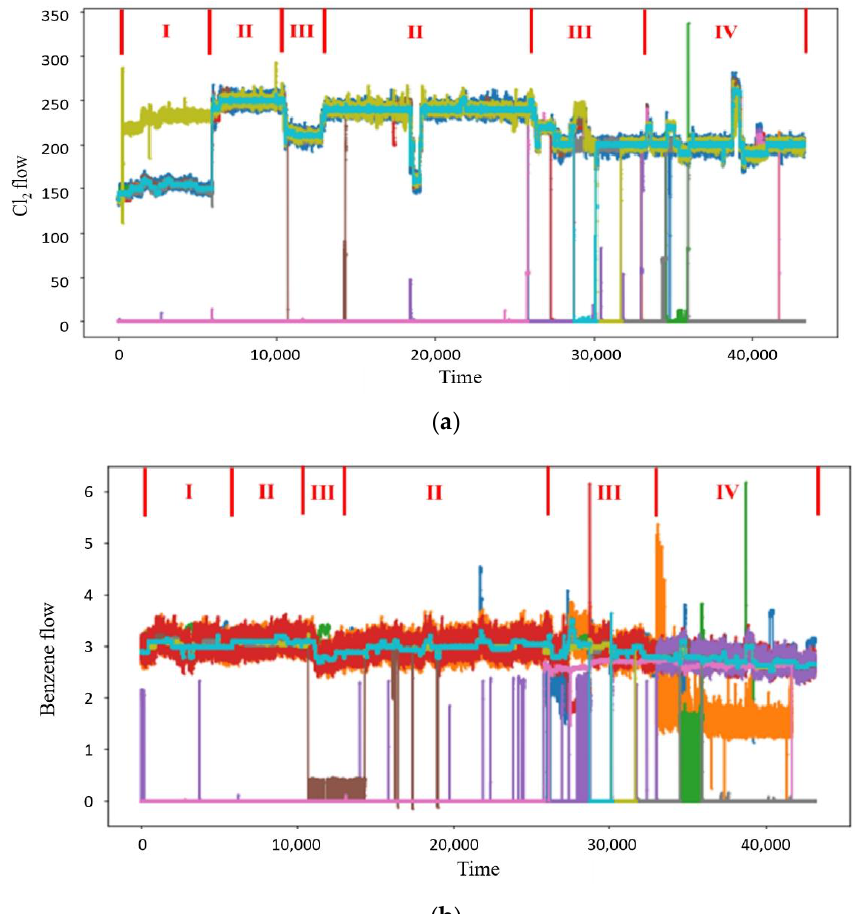
Figure 16. The flows of Cl 2 ( a ) and benzene ( b ) for 10 chlorinators.